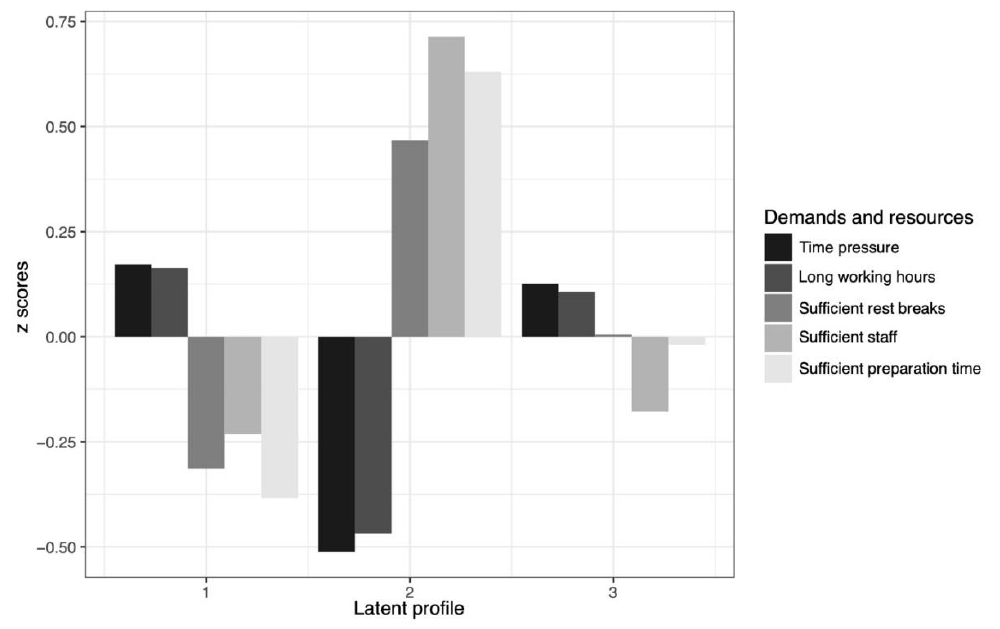
Figure 1. Latent profile solution for demands and resources (z-scores: time pressure, long working hours, sufficient rest breaks, sufficient staff and sufficient preparation time)